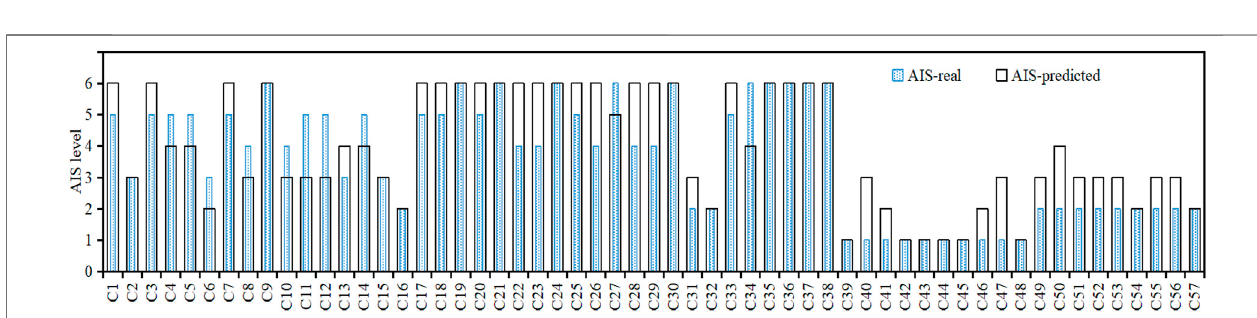
FIGURE 5 | Comparison of pedestrian head injury AIS level between reconstructions and real-world cases.